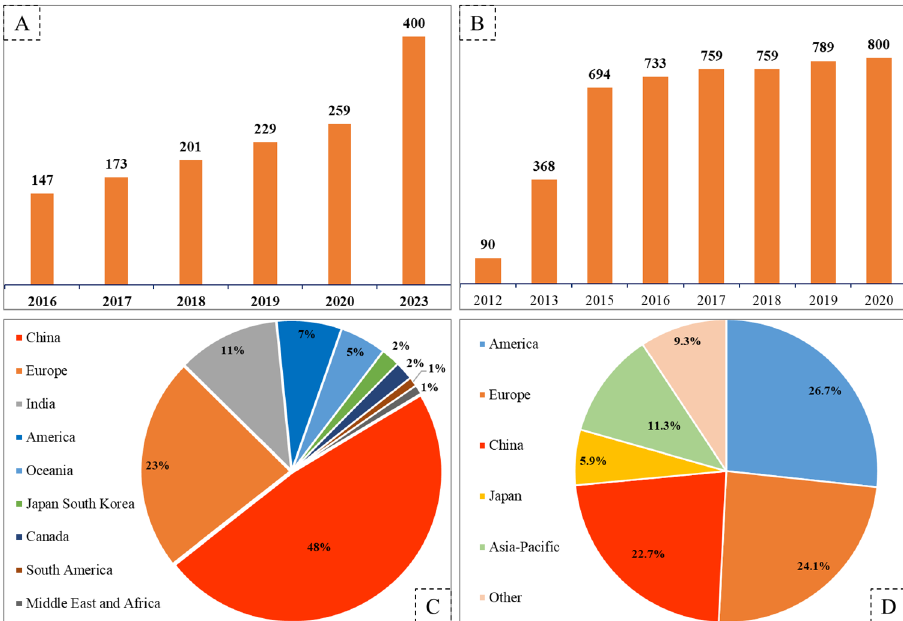
Figure 5. Smart city construction in China. ( A ), the number of smart cities constructed in China in recent years (data source: Qianzhan Industry Research Institute); ( B ), investment scale of smart cities in China; ( C ), proportion of the number of smart cities constructed in major countries; ( D ), proportion of smart city investment scale in major countries around the world.